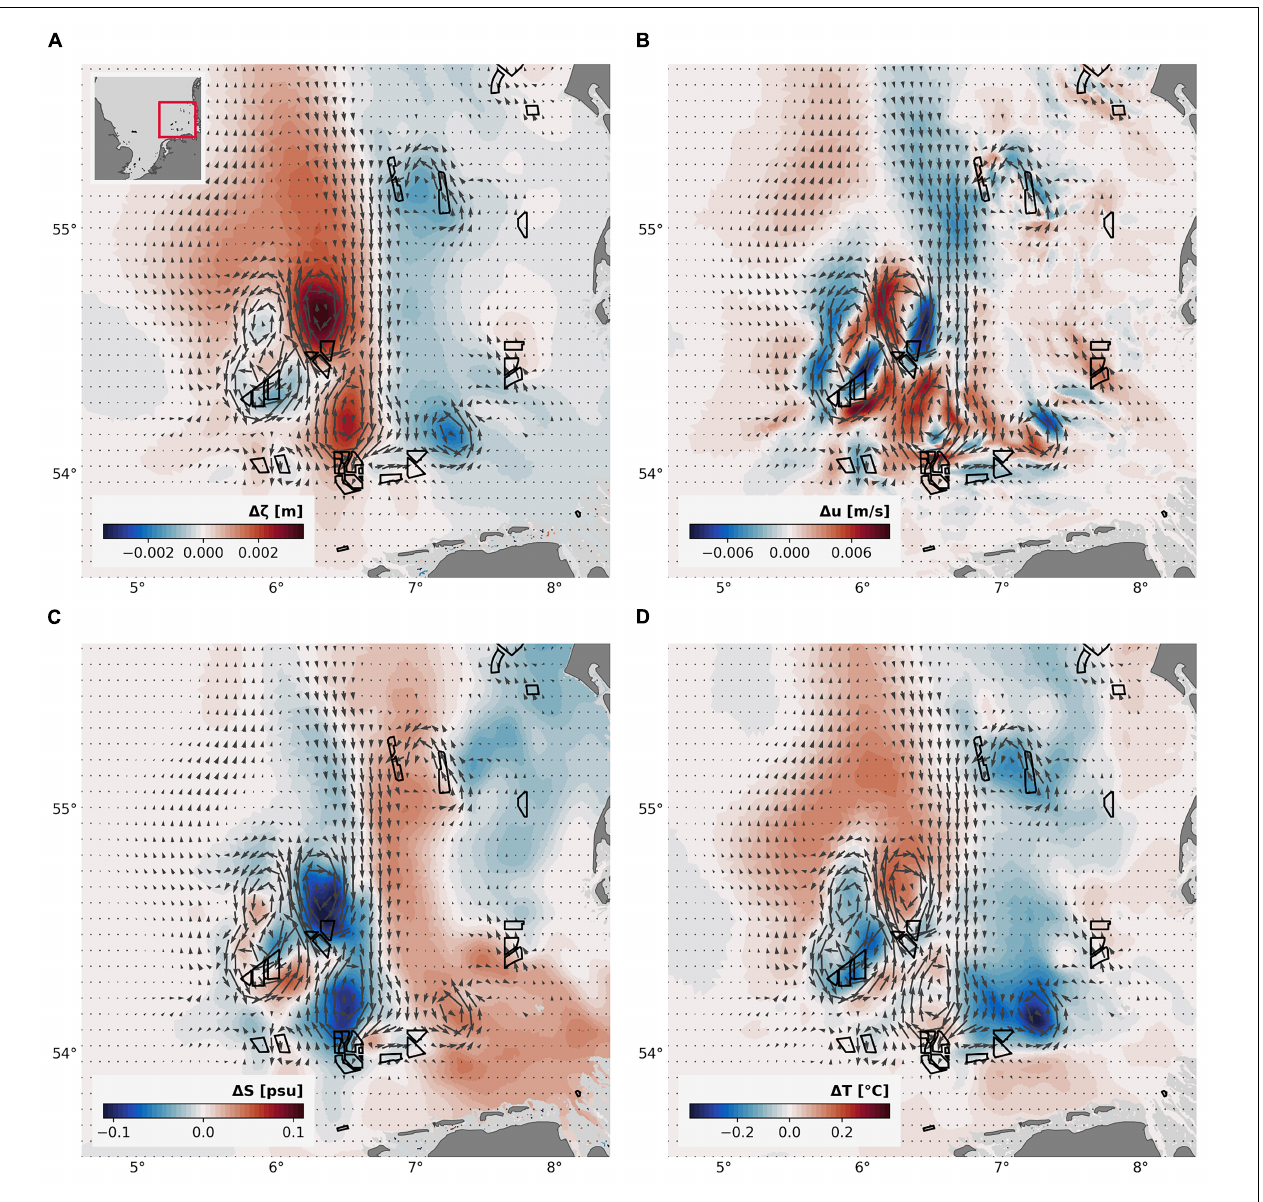
FIGURE 8 | Mean changes in sea surface elevation ζ (A) , depth-averaged velocity u (B) , depth-averaged salinity S (C), and depth-averaged temperature T (D) in the German Bight for the month of August 2013. The black arrows indicate the direction of the changes in depth-averaged velocity. Black polygons indicate offshore wind